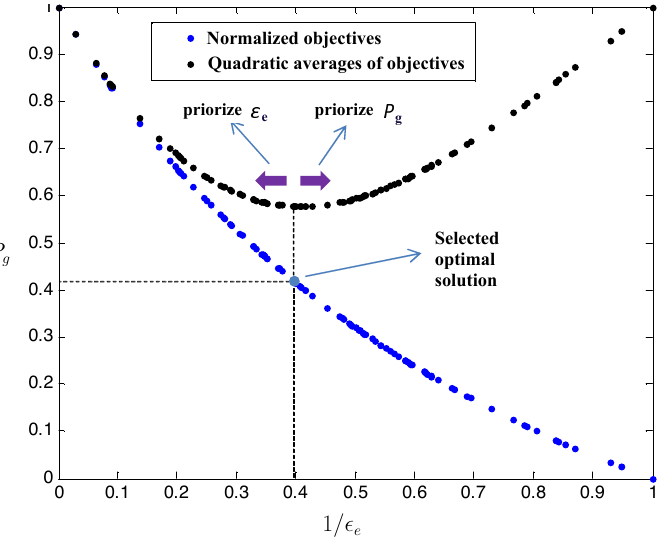
Figure 2. Illustration used to motivate the usage of the selection criterion of the best solution.